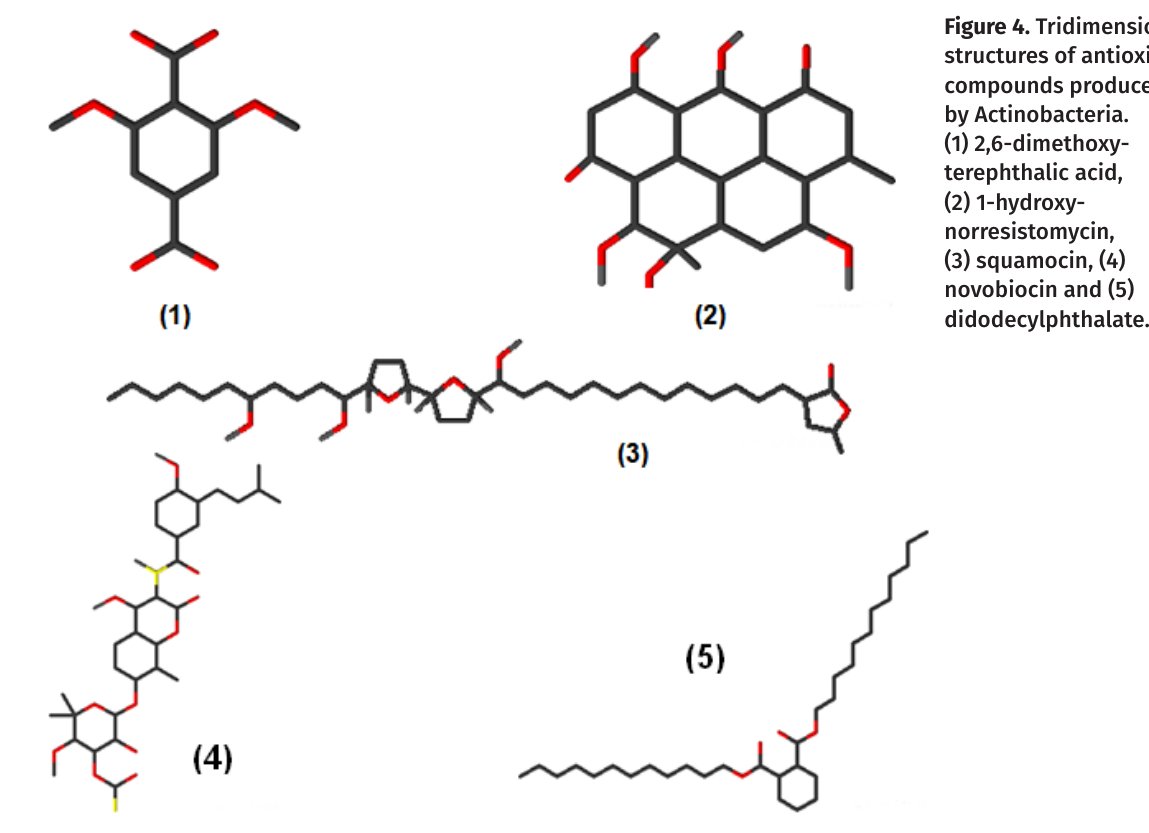
Figure 4. Tridimensional structures of antioxidant compounds produced by